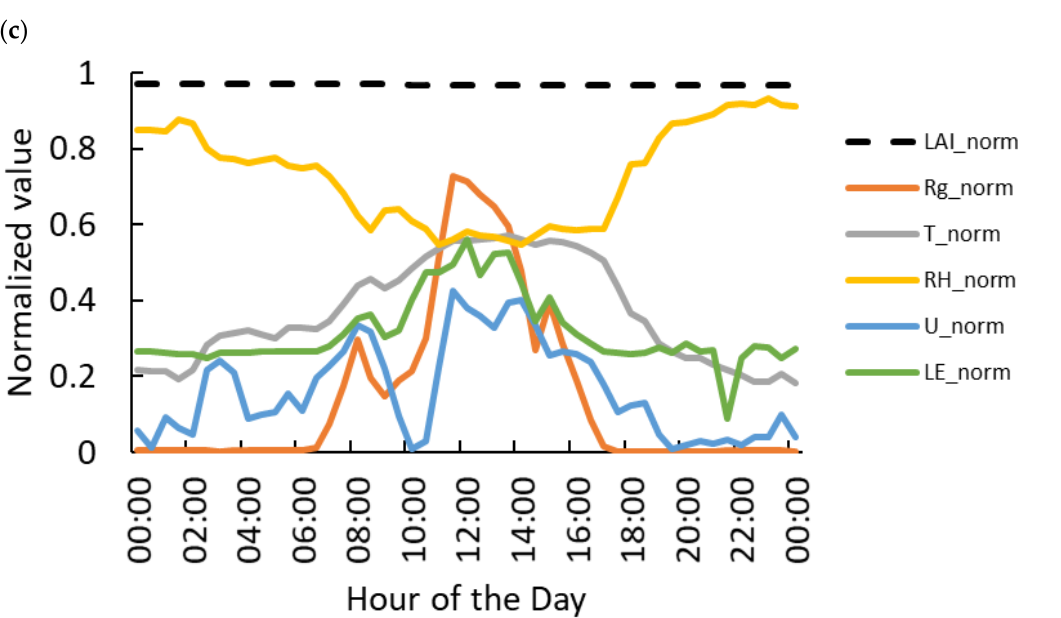
Figure 2. Diurnal courses of the main variables during a typical day ( a ) 27 June; ( b ) 14 August; and ( c ) 4 November 2017. The variables were normalized to the range 0–1, using each variable’s minimum and maximum value throughout the 2017 season. LAI —Dashed black; Rg —orange; T —grey; RH —yellow; U —light blue; LE —green.